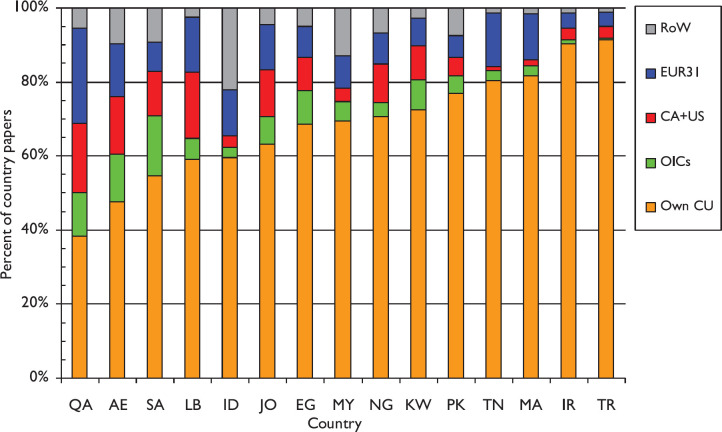
The proportion of outputs through collaboration by the leading OIC countries with others in the group, Canada and the USA, the EUR31 countries and the rest of the World (RoW), for 2008–17. For ISO2 country codes, see Table 1.